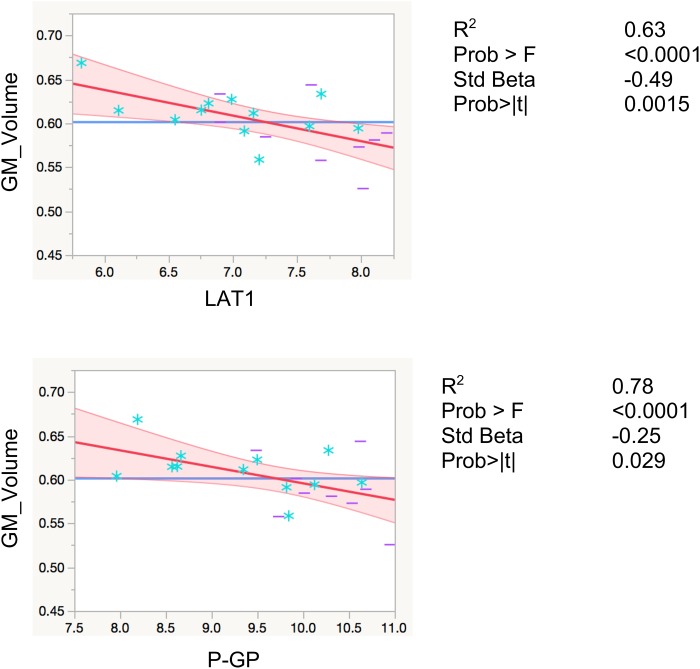
Regression models with global gray matter volume. Associations of EDE cargo proteins with total gray matter volumes. This figure shows leverage residuals plots of global gray matter volumes regressed on normalized EDE cargo biomarkers. Units for gray matter volumes entered into the model are mm3. Age in years and total intracranial volumes in mm3 were controlled for in all regressions. R2 values are adjusted for number of predictors in regression model. All values are rounded to two significant digits. GM, gray matter; blue stars, controls; purple dashes, cases.